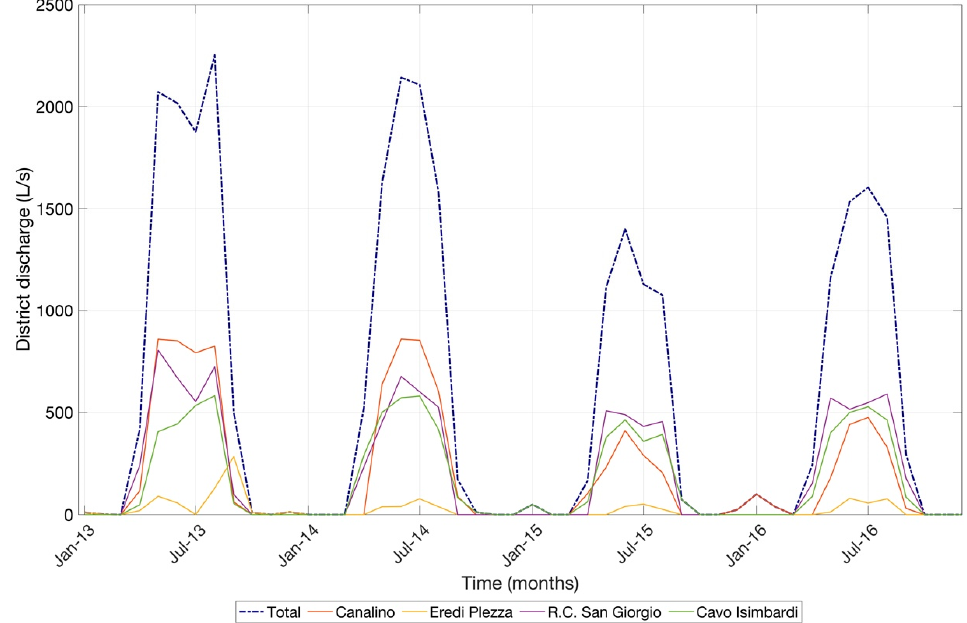
Figure 4. Monthly time series of irrigation water discharges delivered by Associazione Irrigazione Est Sesia (AIES) to the western part of San Giorgio district in the period 2013–2016.